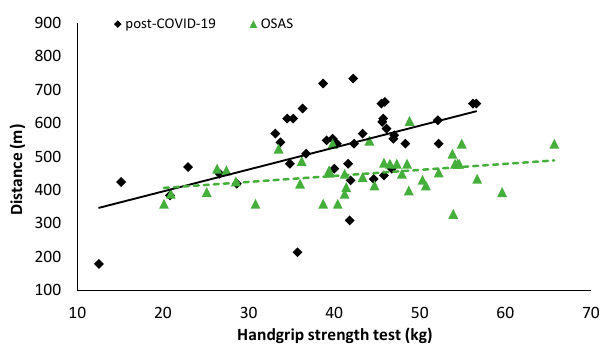
Figure 4. Correlation analysis results between the handgrip strength test and distance during the 6MWT (post-COVID-19: r = 0.540, p < 0.001; OSAS: r = O.322, p = 0.044).